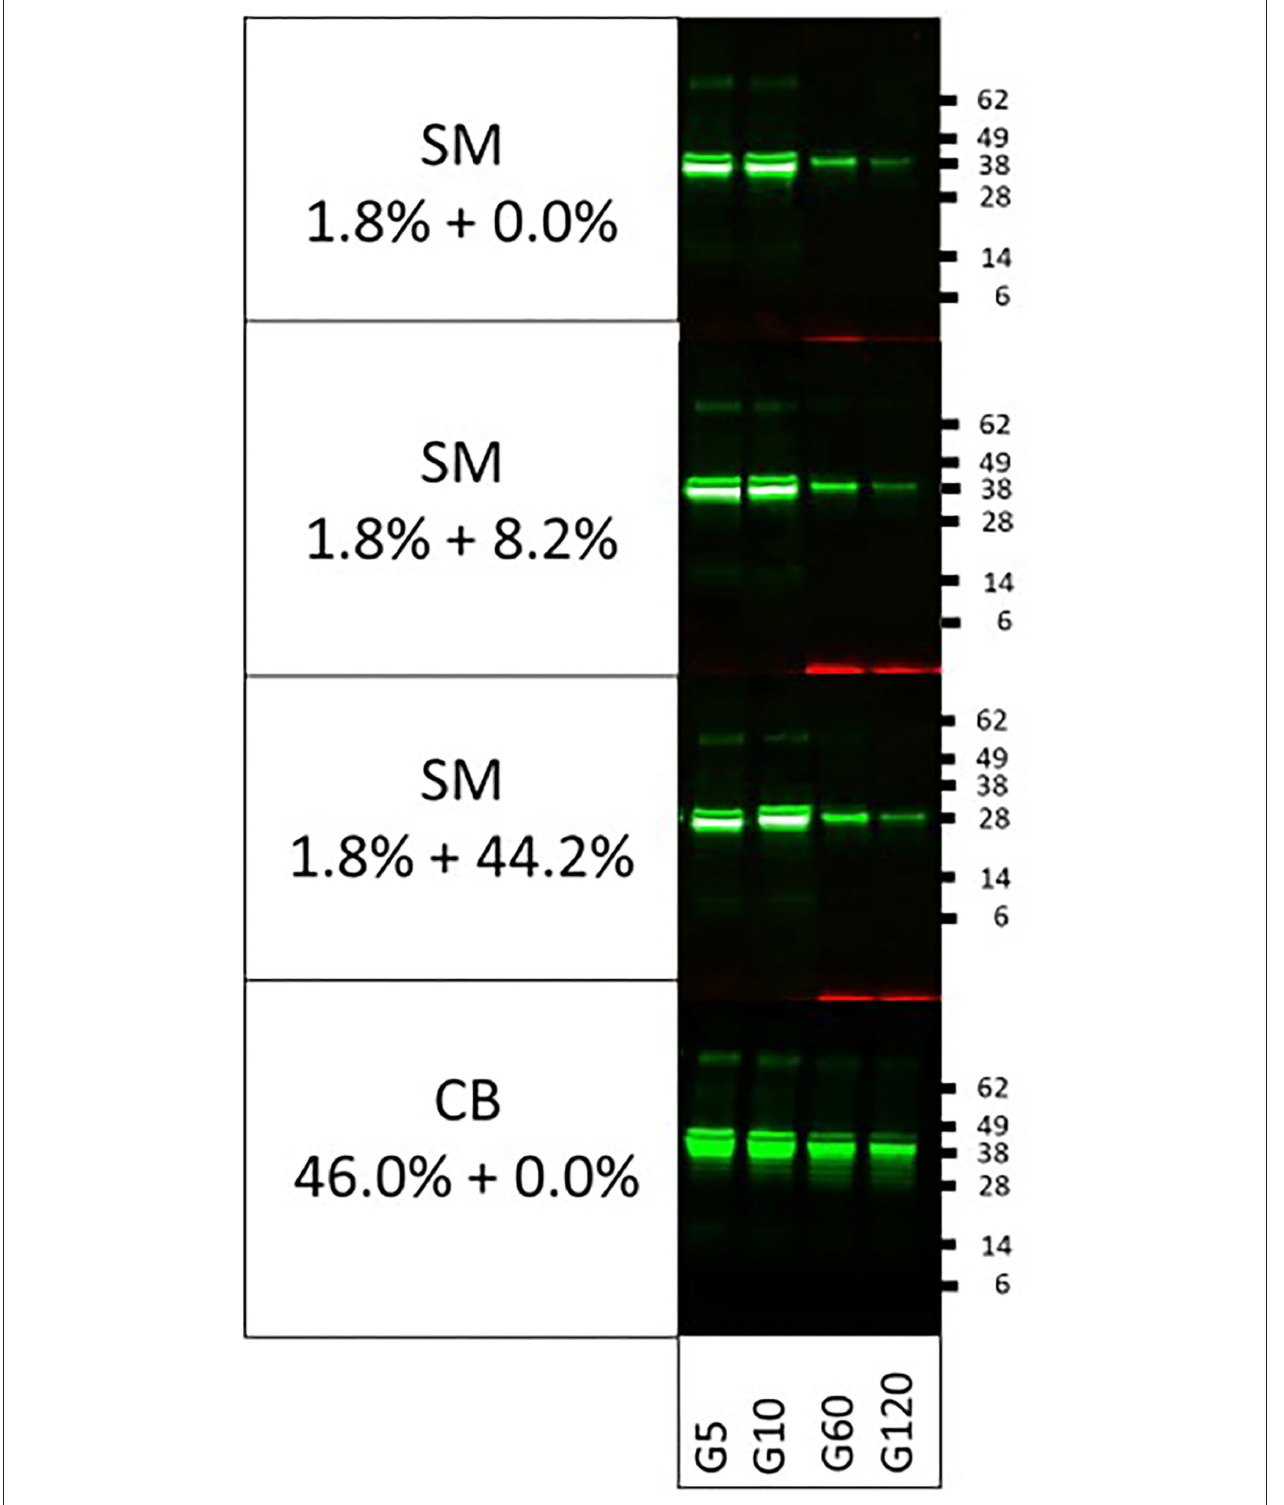
FIGURE 3 | Impact of the addition of extra fat to soy milk on pepsin digestion of porcine tropomyosin. DM, dessert mousse; SM, soy milk; CB, chocolate bar. Samples were taken at 5 (G5), 10 (G10), 60 (G60), and 120 (G120) min. Samples were analyzed by immunoblot with respective tropomyosin-specific antibodies. Molecular weight markers are indicated on the side in kDa. Cocoa butter was added to SM to reach the percentage of fat reported for the DM and CB matrices, respectively.